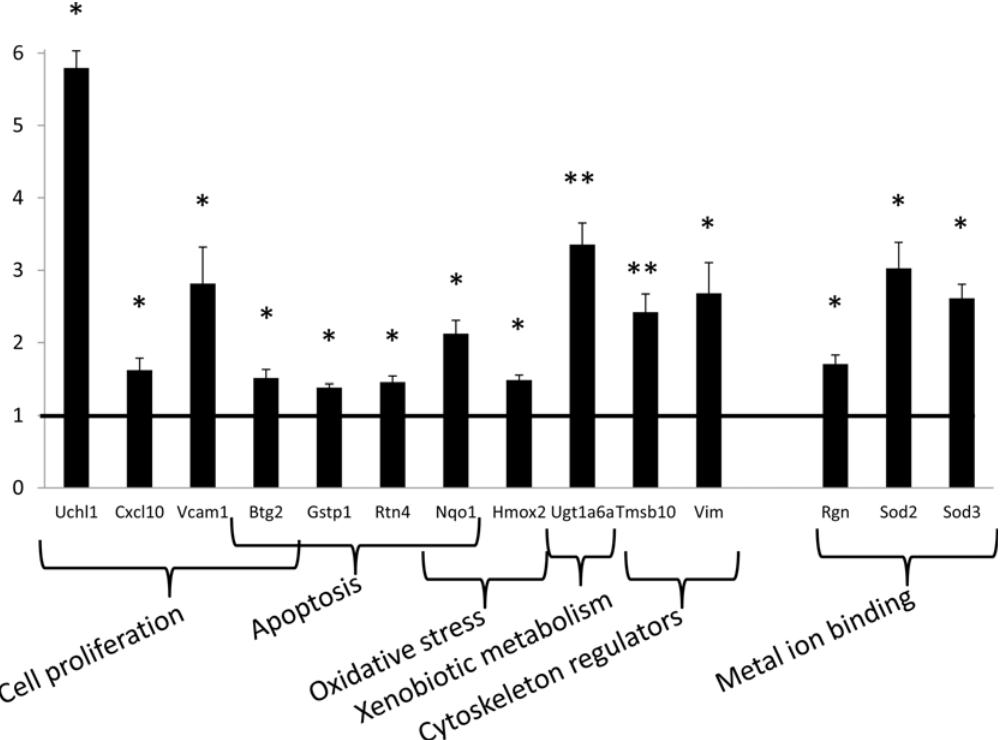
Fig 8. Kidney gene expression in Lcat-/- mice after LpX treatment. The expression of 84 genes involved in nephrotoxic pathways was measured. Only genes whose expression was statistically different between LpX- treated vs saline-treated Lcat -/- mice are reported. Data are expressed as mean ± SEM. * P < 0.05, ** P < 0.01, paired